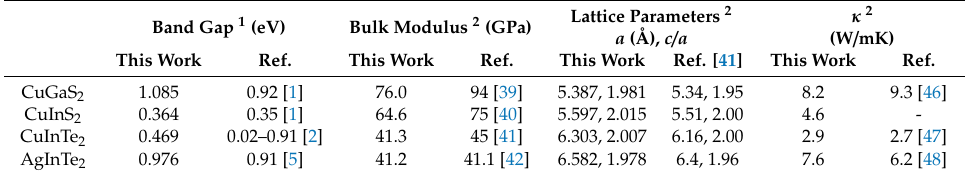
Table 1. Comparison between calculated and reported values for band gap, bulk modulus, lattice parameters, and thermal